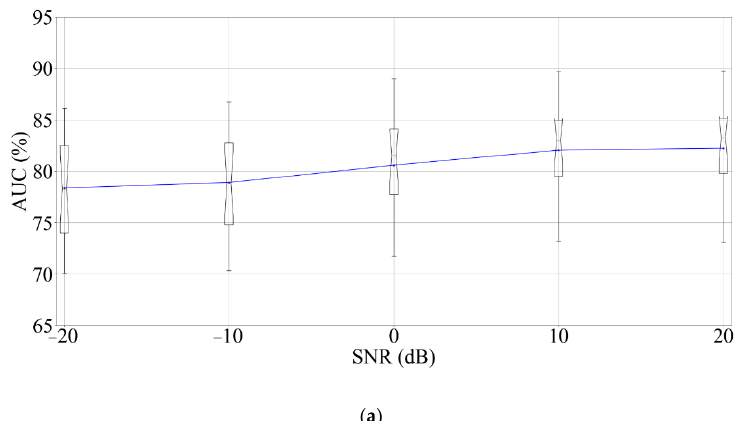
( b ) Figure 6. Boxplots indicate the average values for the simulations where AWGN is introduced in the EEG signals, evaluating the 16 subjects using LOO for the models optimized by ( a ) GA, and ( b ) PSO. 4. Discussion A comparison between the results reported by the previous state-of-the-art works and the results attained in this work is presented in Table 4. By examining the table, it is clear that the previous works that have only studied FNB subjects achieved the best per- formance, highlighting the difficulties associated with the assessment of subjects with sleep disorders. Although the use of sleep disorder subjects made the classification pro- cess more challenging, the produced results can be better generalized for clinical applica- tions. Another relevant factor is the average number of examined subjects, which was 12 in the state-of-the-art works. In contrast, 18 were examined in this work, emphasizing the viability of the achieved results. It is also important to highlight here the examination of multiple channels considering that, apart from Sharma et al. [60], who evaluated two EEG channels, all state-of-the-art works examined only one EEG channel, which is contrary to the recommendation to score CAP utilizing multiple channels [29], given that an A phase can only be scored if it is visible in all EEG channels. The relevance of using multiple